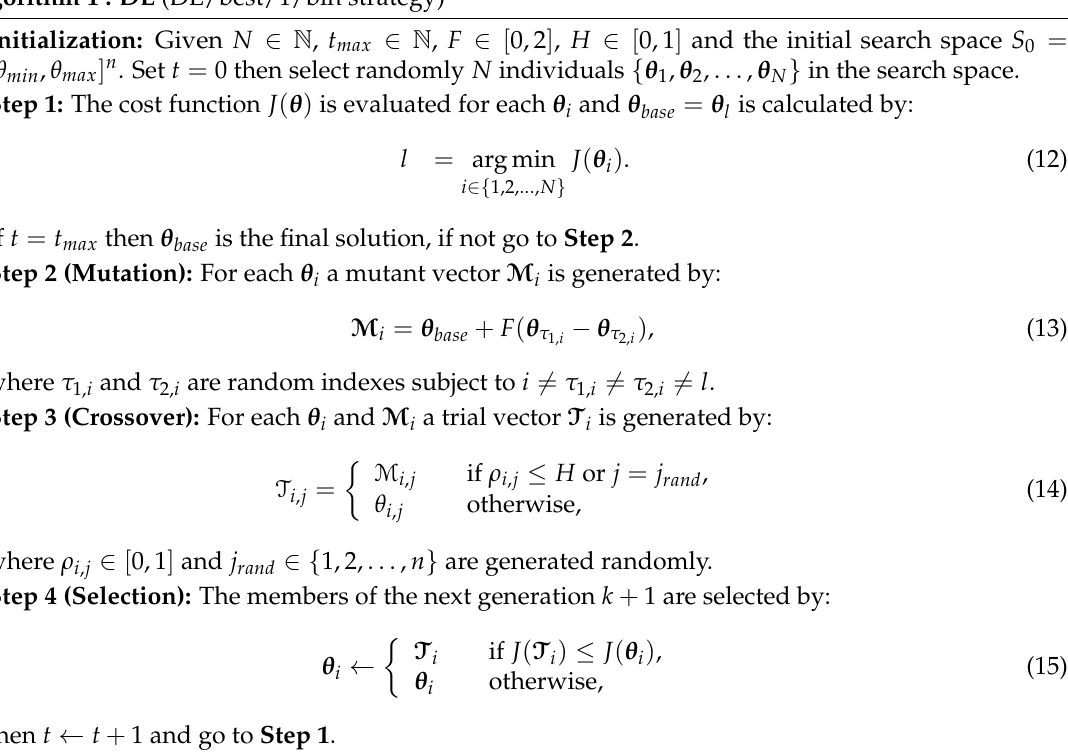
Algorithm 1 : DE (DE/best/1/bin